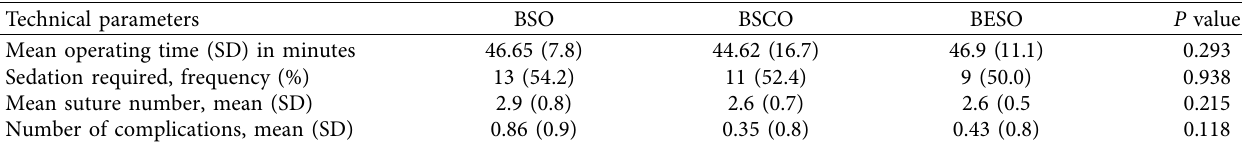
Table 3: Summary of perioperative